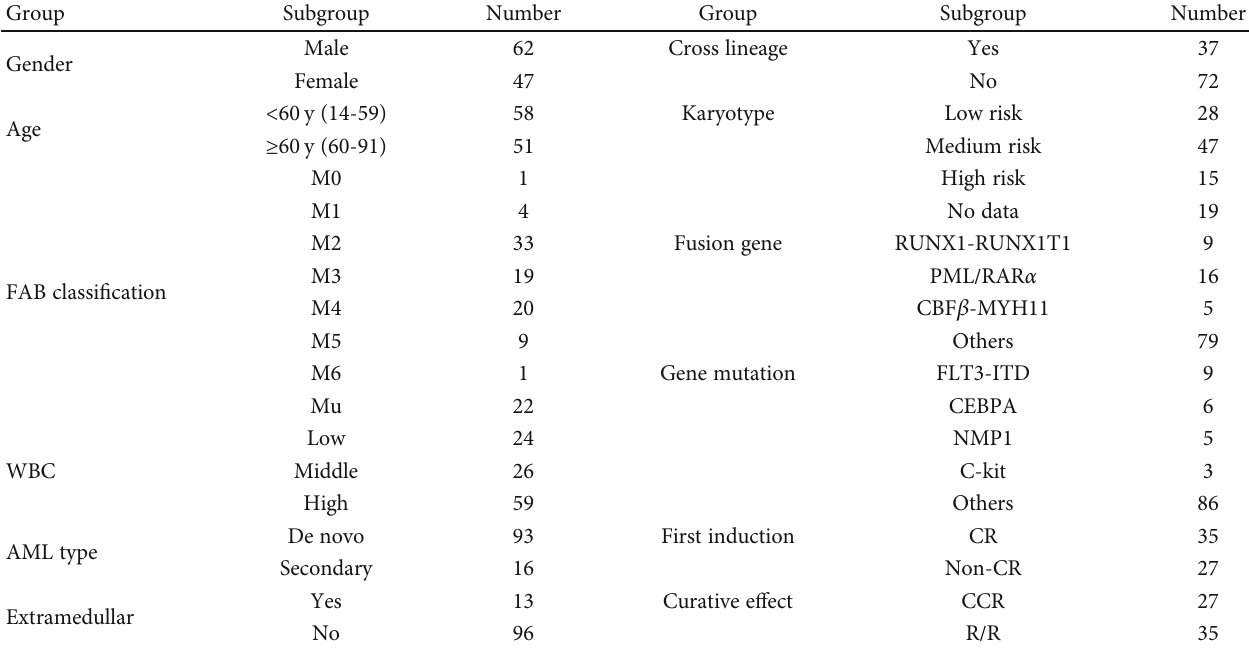
Table 1: Characteristics of 109 newly diagnosed patients with